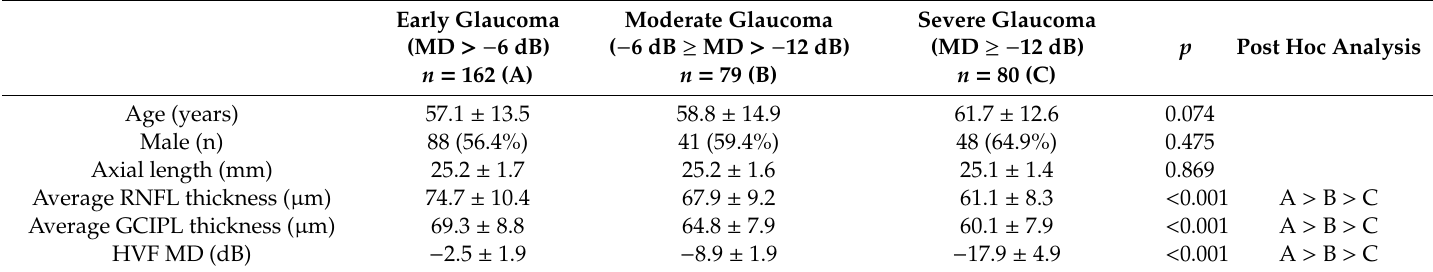
Table 2. Comparisons among subjects from the internal validation set according to glaucoma